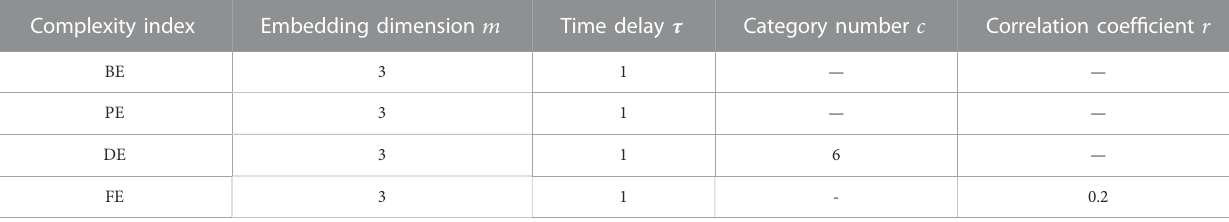
TABLE 1 Parameter settings for each type of